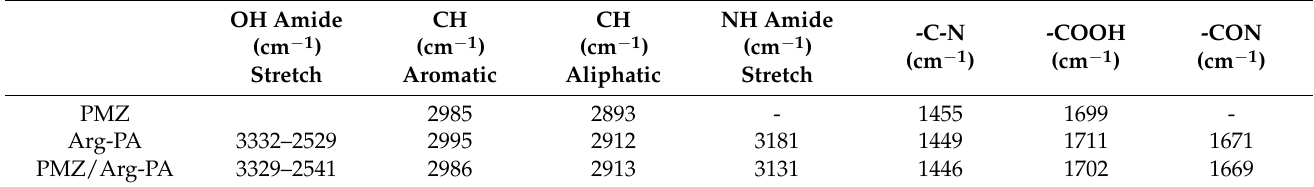
Table 2. FTIR spectral properties of PMZ, Arg-PA, PMZ/Arg-PA.